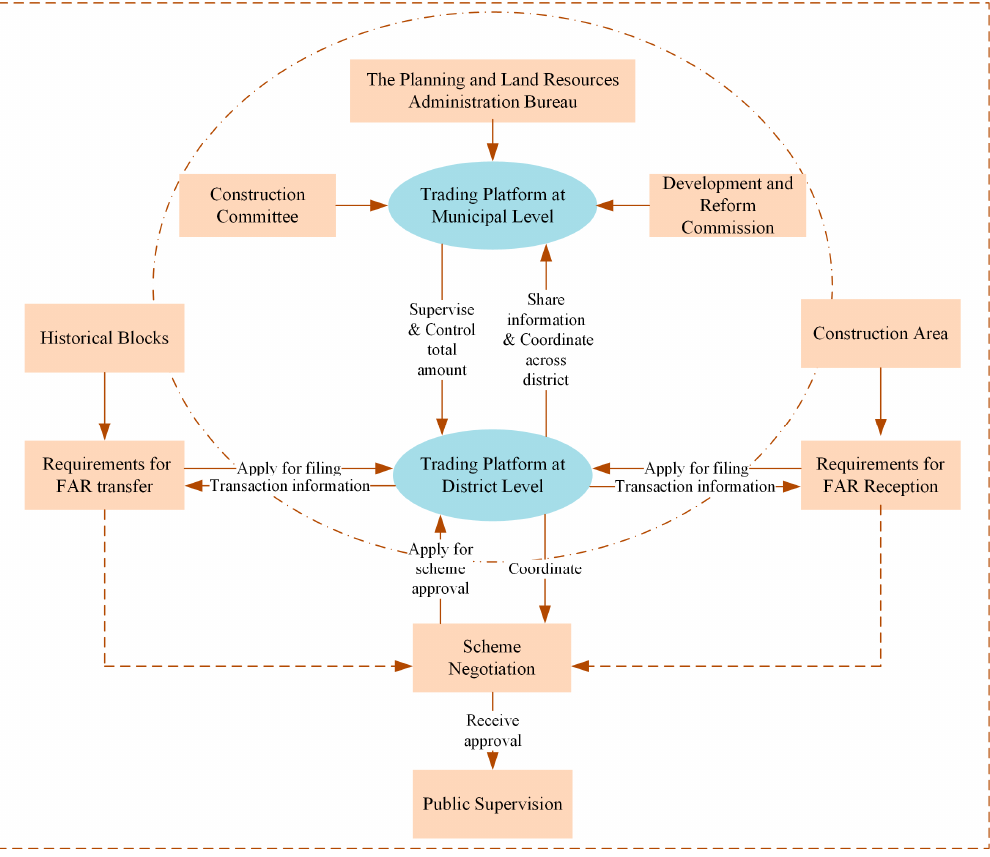
Figure 4. The FAR trading platform at the municipal and district level.